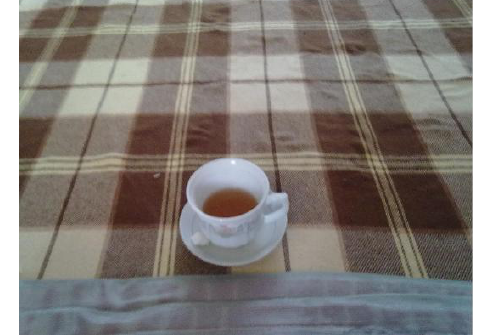
Figure 6. An image that its background pattern is full of edges (Original resolution 1600*1200).